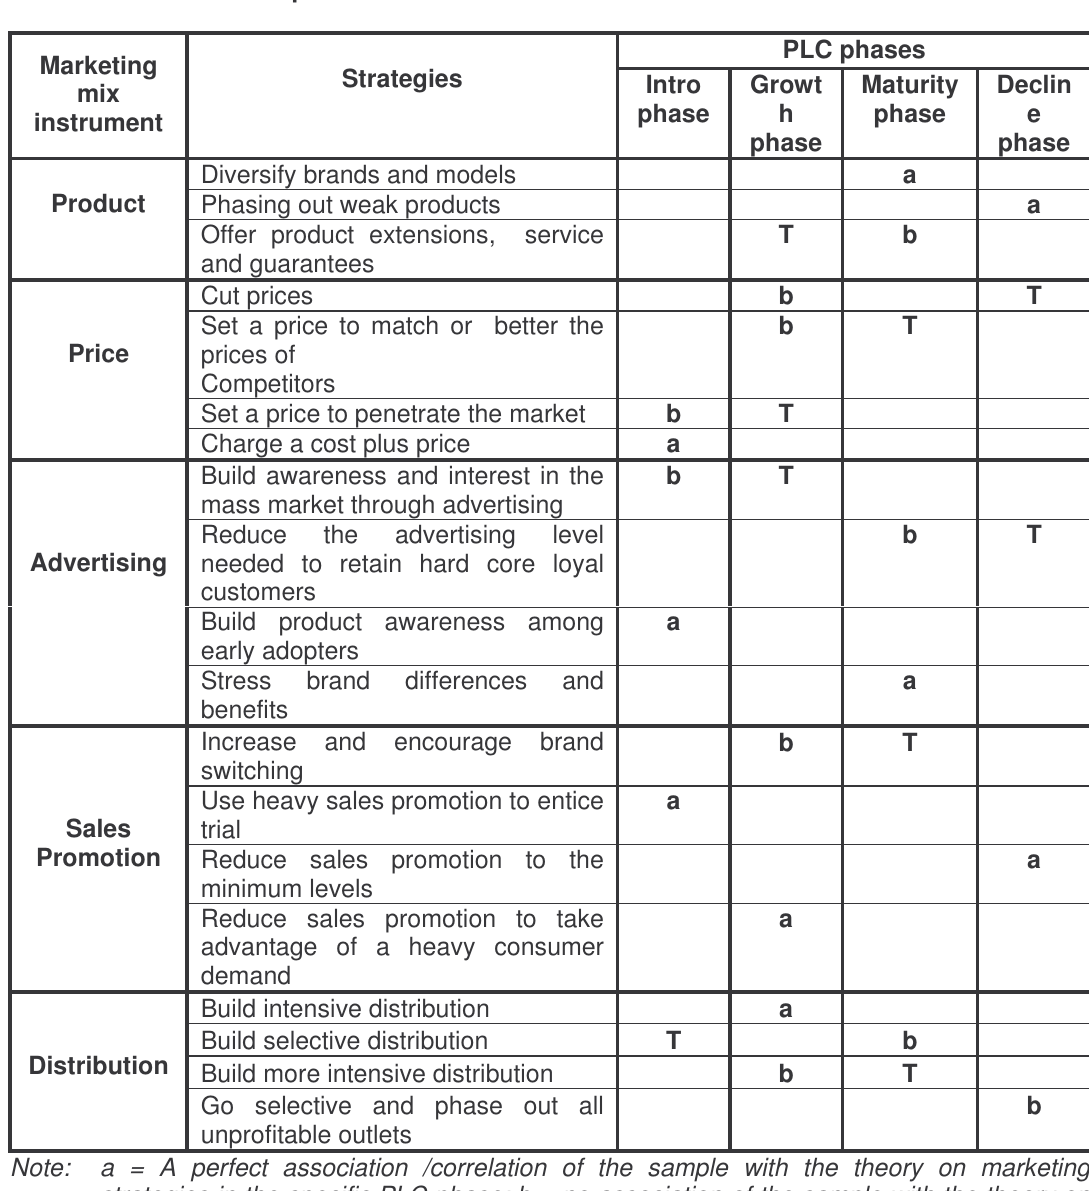
Comparison of the total sample response of marketing strategies in each of the PLC phases